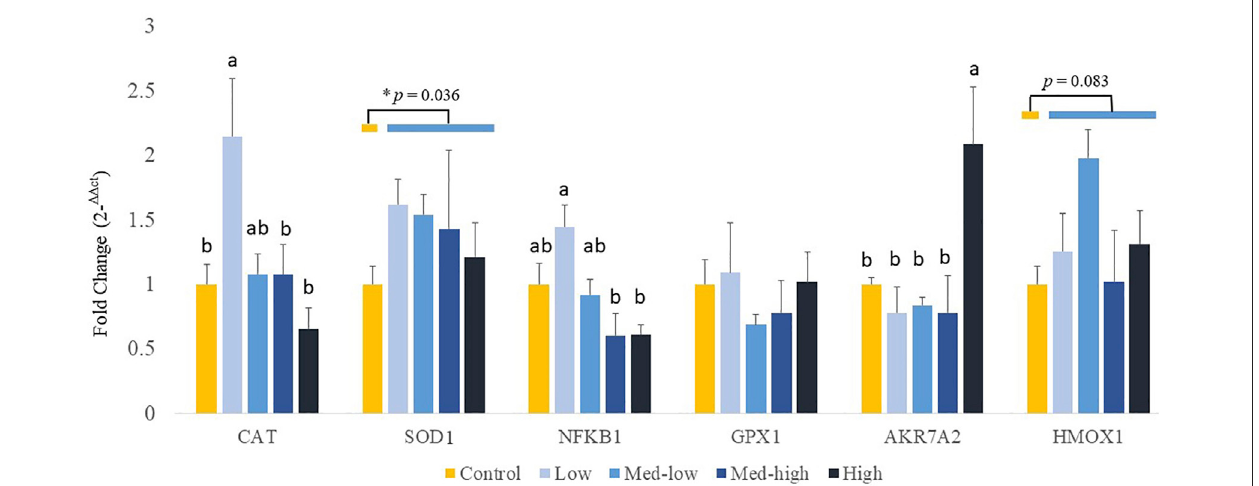
FIGURE 4 | Effects of increasing oocysts dose of Eimeria mix on antioxidant-related transcripts gene expression in the liver of broilers. Low, the lowest challenge dose; Med-low, the medium-low challenge dose; Med-high, the medium-high challenge dose; High, the highest challenge dose. CAT, catalase; SOD1, superoxide dismutase1;NFKB1,nuclearfactorkappaBsubunit1;GPX1,glutathioneperoxidase1;HMOX1,hemeoxygenase1;andAKR7A2,a fl atoxinaldehydereductase. a,ab,b Treatments with different letters means a signi fi cantly difference between treatments by using Tukey ’ s HSD test, p < 0.05, N = 6. * a signi fi cant difference between non-challenge control and pooled challenge groups (Low, Med-low, Med-high, and High) by using Welch ’ s t -test, p < 0.05.